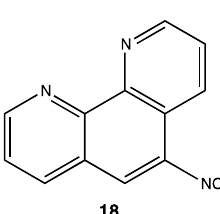
Figure 8. 5-nitro-1,10-phenantroline compounds tested against Mycobacterium tuberculosis [31].